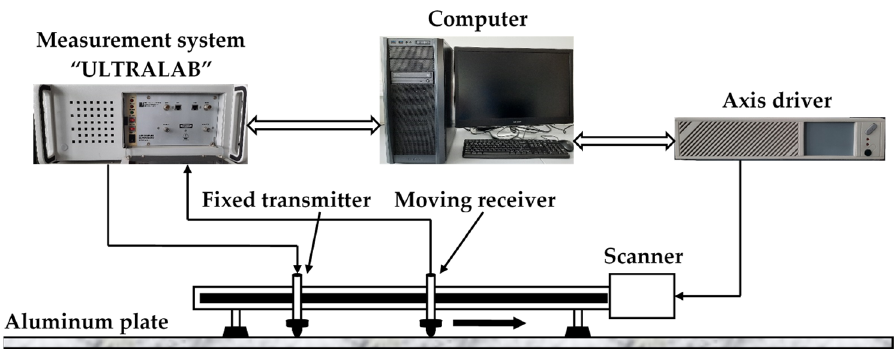
Figure 8. The structural scheme of Lamb wave A 0 mode signal generation and recording in an aluminum plate.